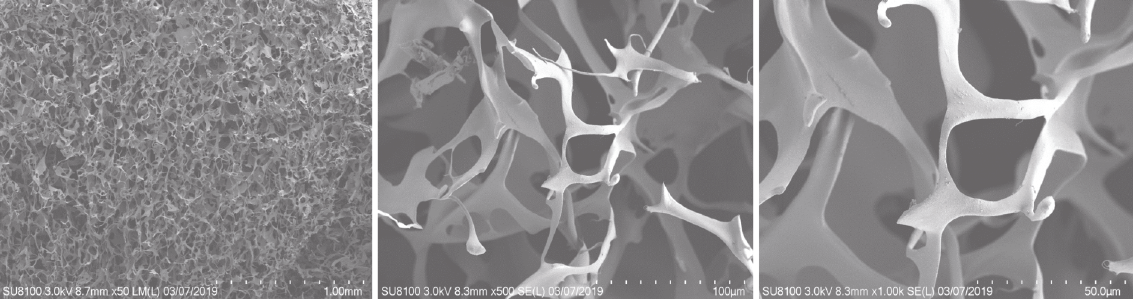
Figure 2: Scanning electron microscope observation of cellulose composite hemostatic material.